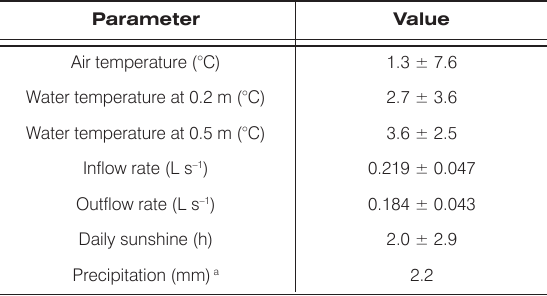
Table 1. Hydrological parameters and characteristics of the Slavošovice CW. Parameter